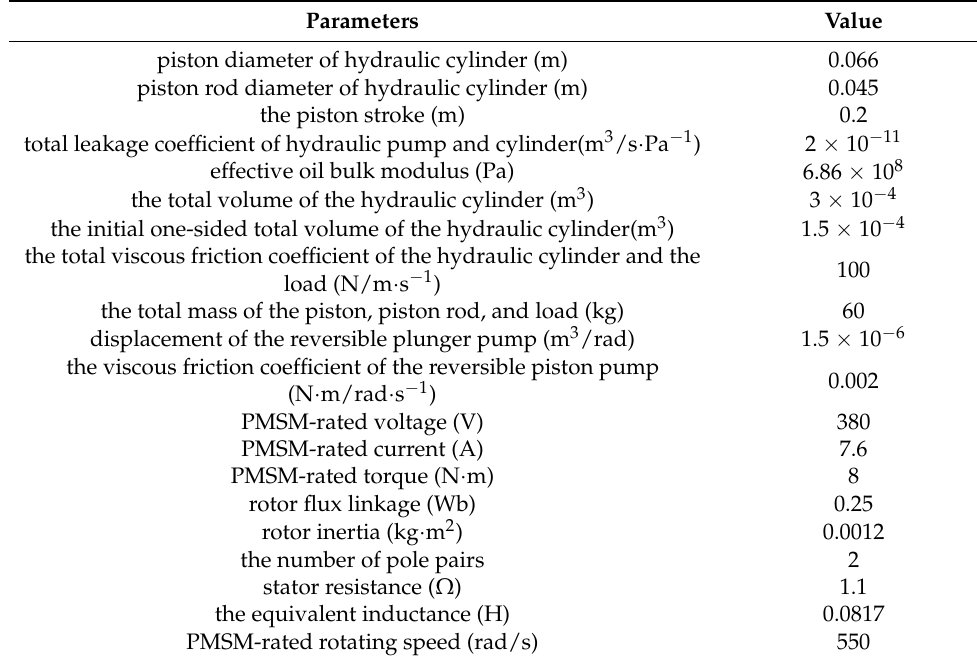
Table 1. The EHA system